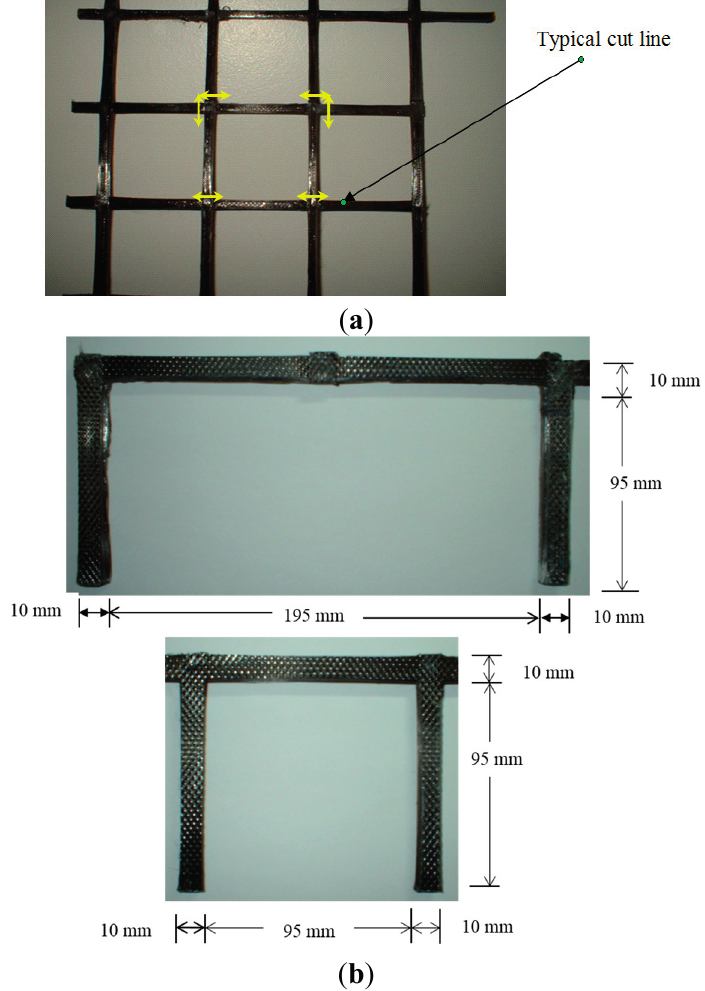
Figure 1. Typical CFRP grid and the proposed anchor. ( a ) CFRP grid; ( b ) Typical anchor